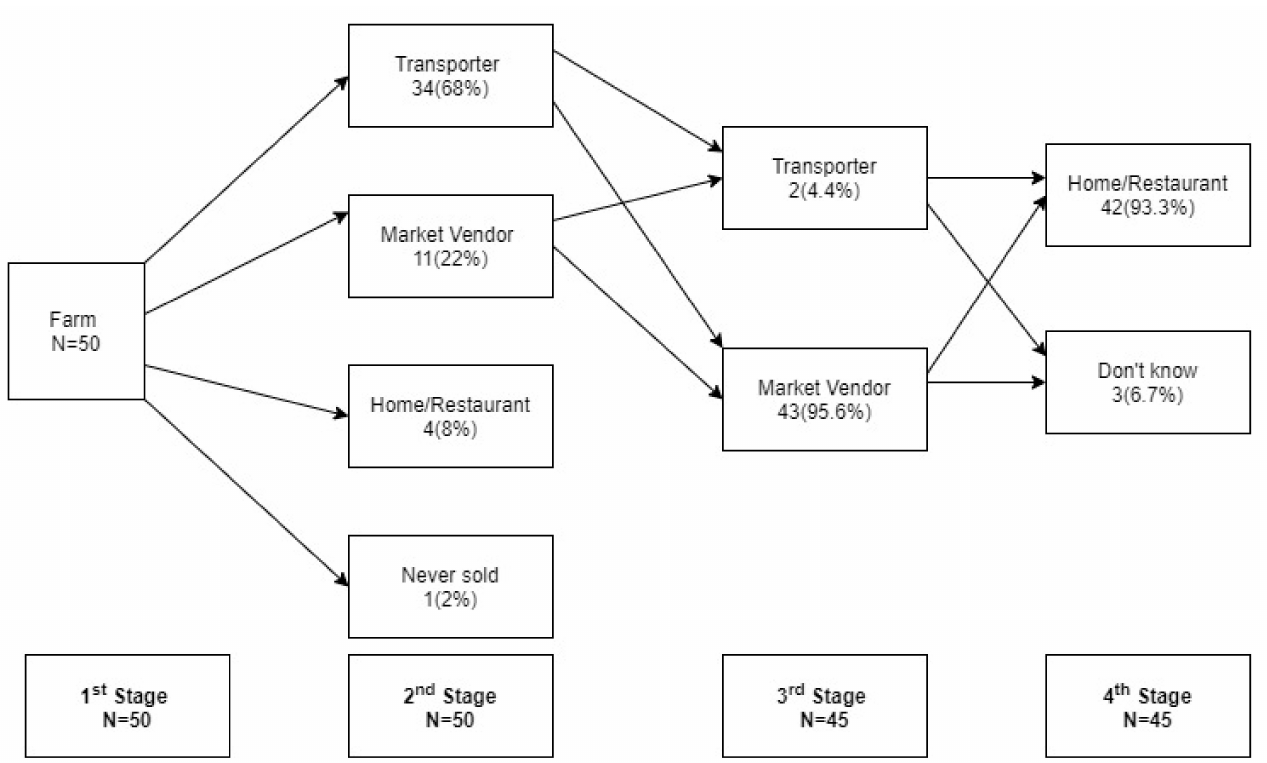
Figure 1. Fruit and vegetable movement along the supply chain from farm to